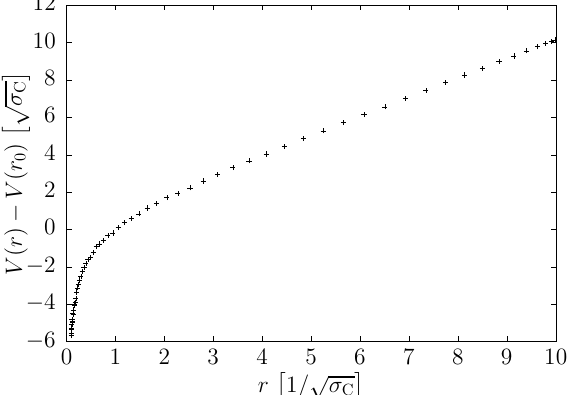
(cid:3) Figure 3. Non-Abelian Coulomb potential (Equation (33)) obtained in the variational approach